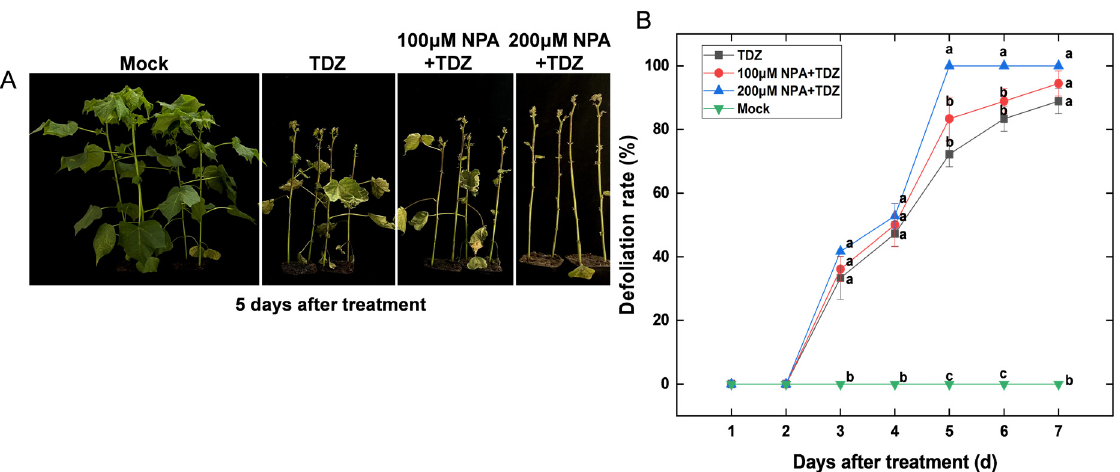
Figure 10. The importance of auxin transport in thidiazuron (TDZ)-induced leaf abscission. ( A ) Representative plants taken at 5 d after treatment with 300 mg/L TDZ, or TDZ plus 100 and 200 µM 1-naphthylphthalamic acid (NPA), respectively. ( B ) Defoliation rate (%) of cotton leaves over time. Error bars represent the SD of three biological replicates. Homogeneous subgroups with significant difference ( p -value < 0.05) are marked by different lowercase letters.